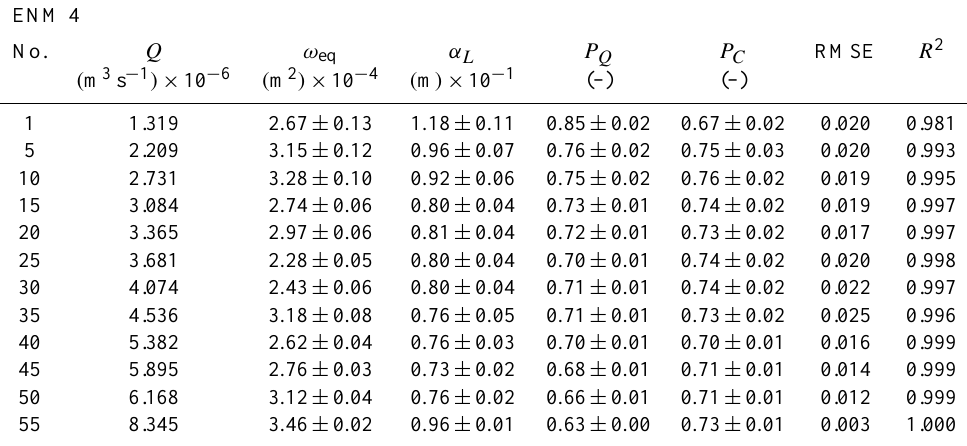
Table 4. Estimated values of parameters, RMSE, and determination coefficient r 2 for ENM4 at different injection flow rates in the fractured